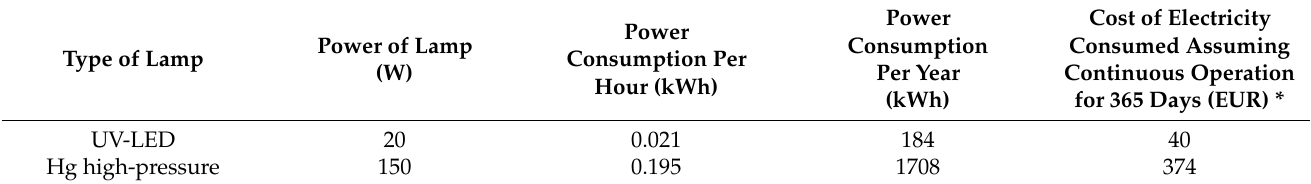
Table 6. Electricity consumption and electricity costs for UV-LED lamps and a high-pressure mer- cury